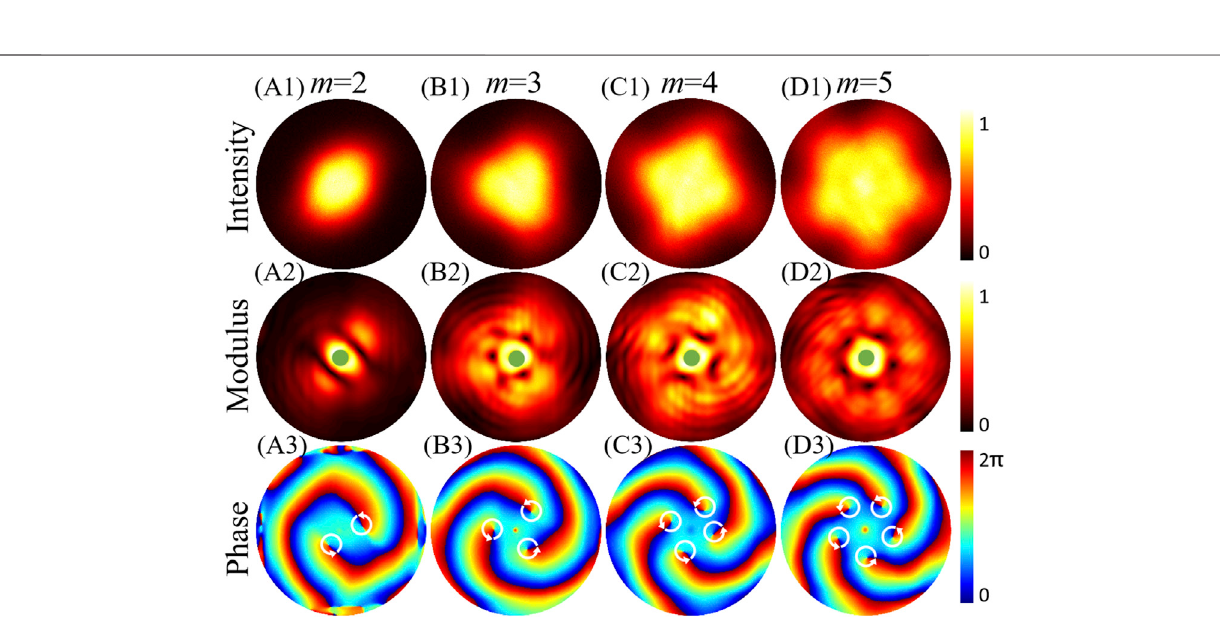
Frontiers in Physics |